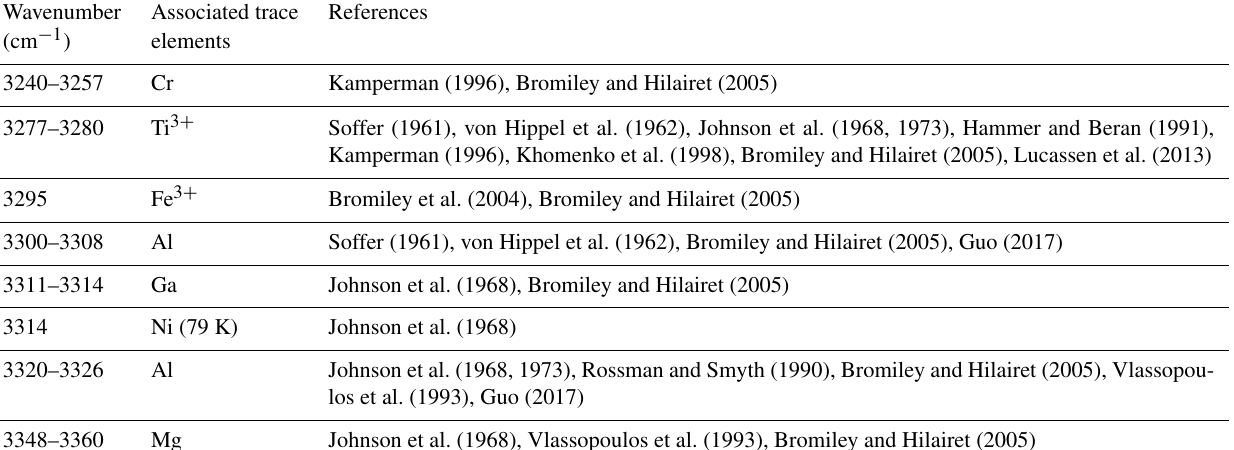
Table 1. OH-band positions of rutile from literature data.